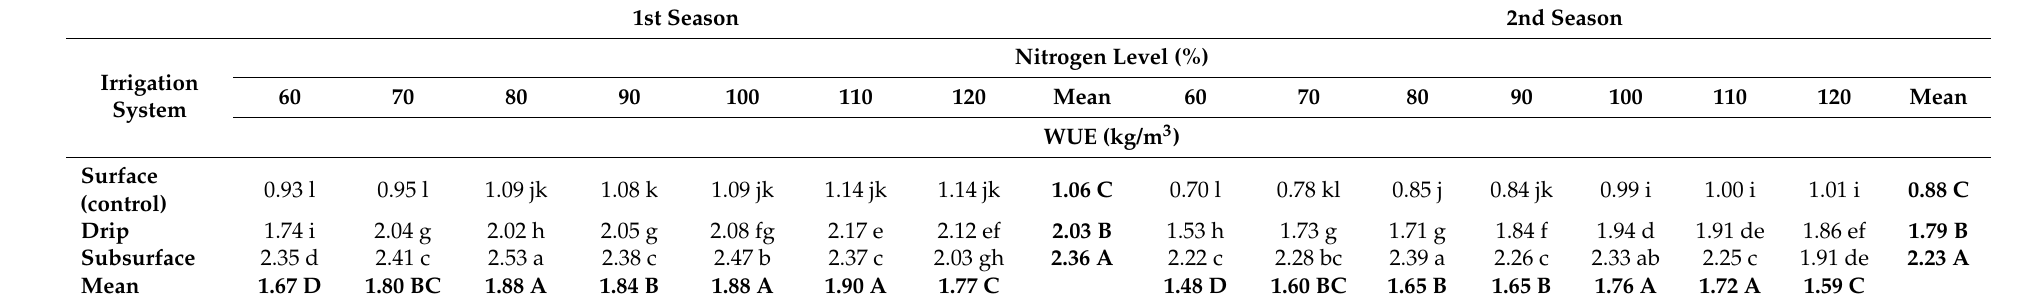
Table 6. Water use efficiency (WUE) at the different irrigation systems and nitrogen treatments in seasons 2019 and 2020.